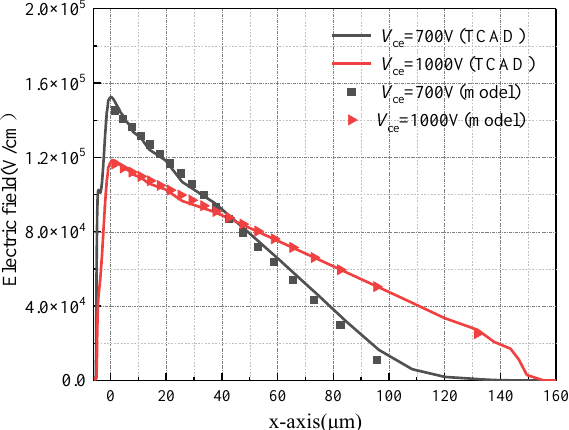
Figure 6. The electric field distribution of the chip vertical path during switching transients. 4.2. Verification of the Temperature Distribution along Chip Vertical Path